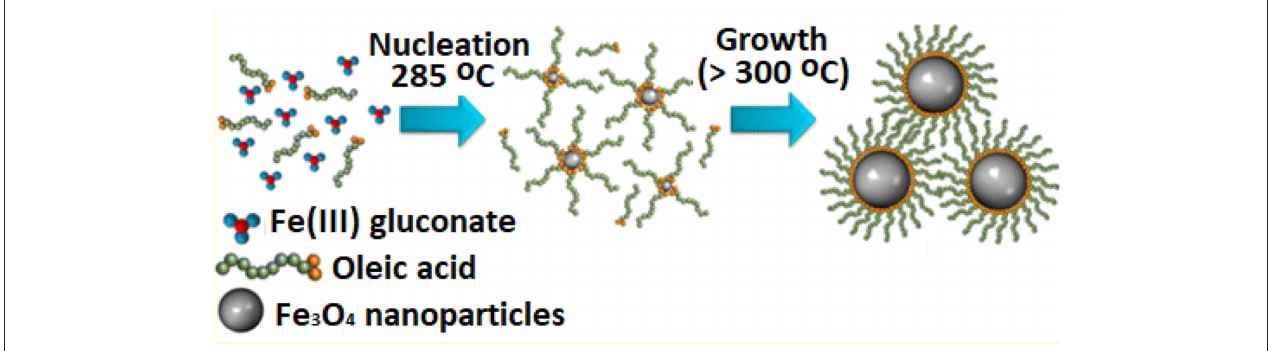
FIGURE 4 | Thermal decomposition of iron(III) glucuronate to synthesize superparamagnetic Fe 3 O 4 nanoparticles [adapted and modified from Patsula et al.